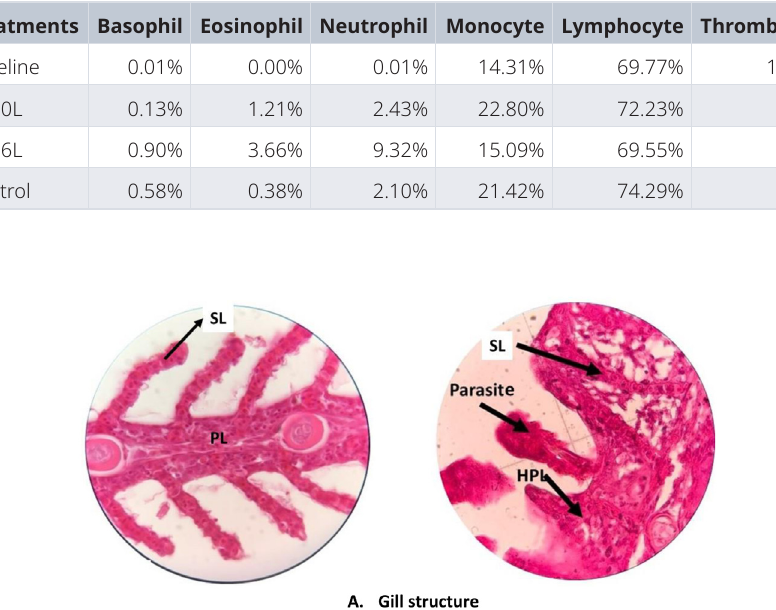
Table 3. Percentage of white blood cell types in Pangasionodon hypophthalmus reared under manipulated photoperiod.